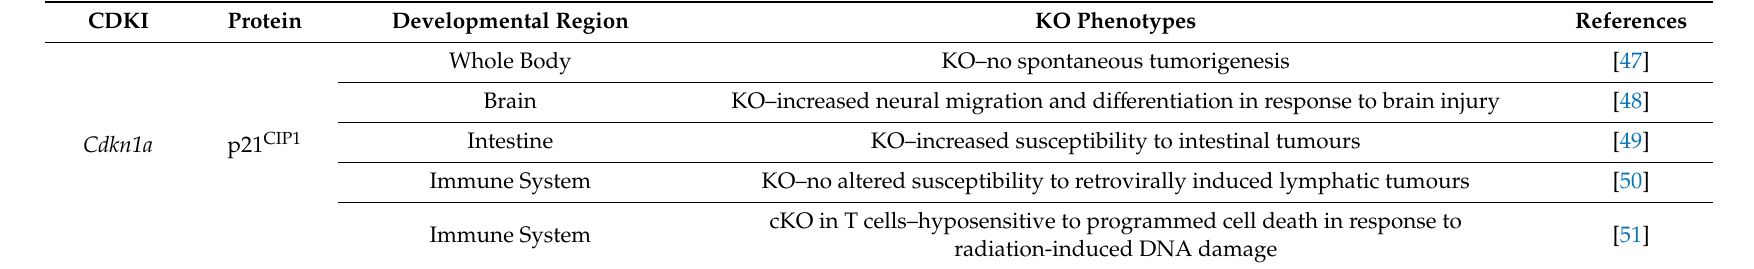
Table 2. Phenotypes of CDKI (cyclin-dependent kinase inhibitors) KO and cKO in